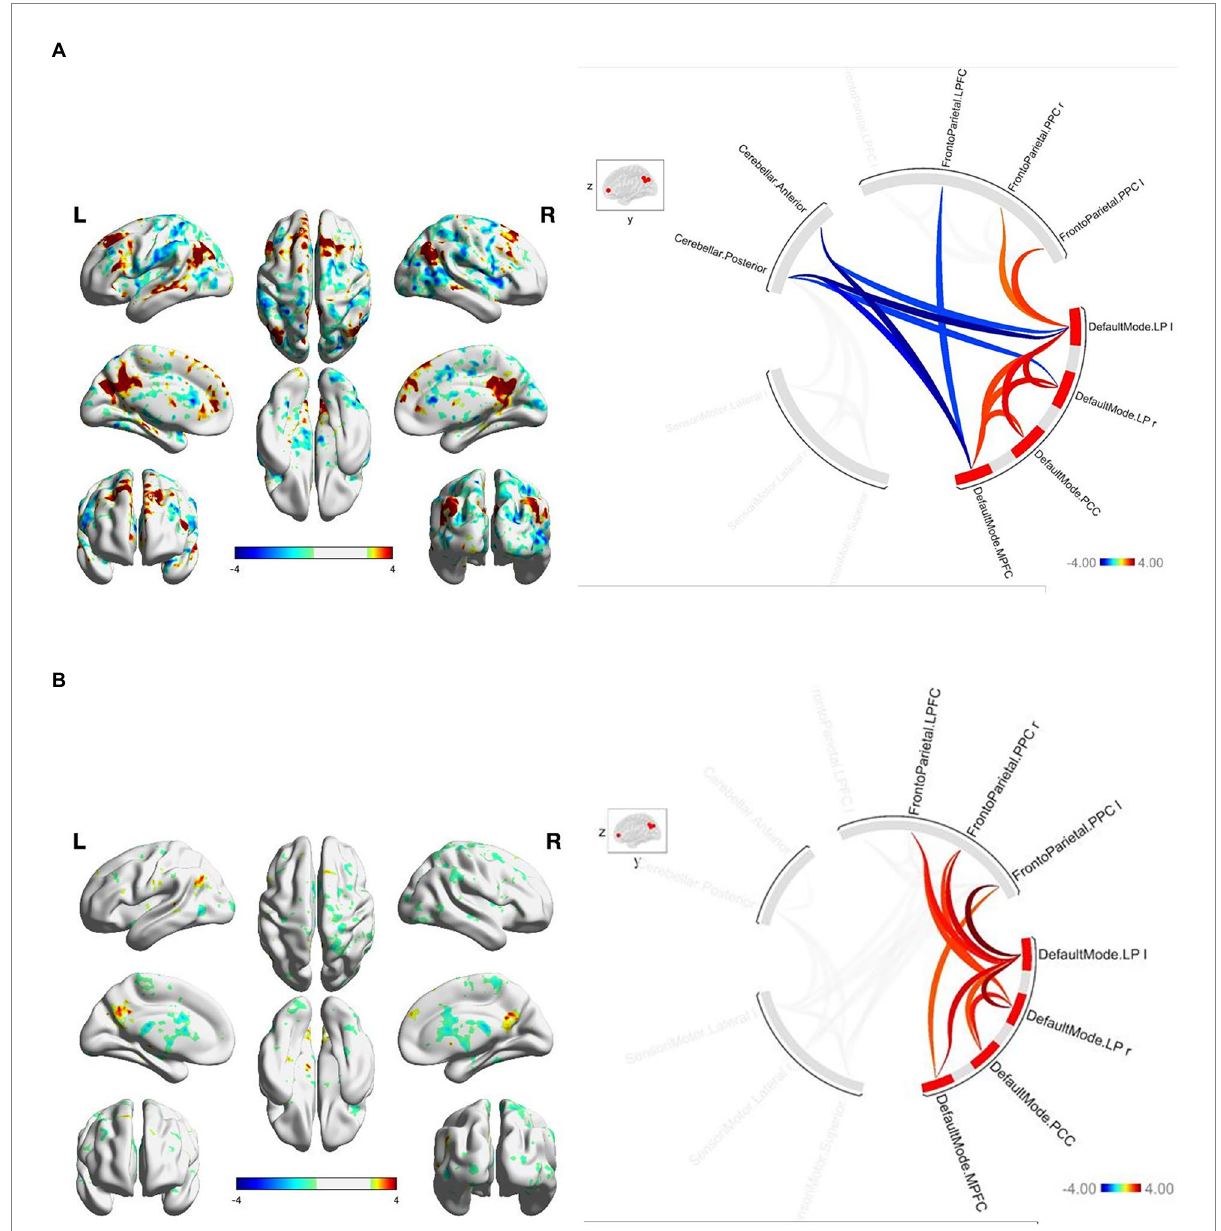
FIGURE 1 (A) FGA-related DMN connectivity at baseline. For connectome ring: bottom right quadrant contains nodes of the DMN, top right quadrant contains nodes of the FPN, the top left and bottom left quadrants contain nodes of the cerebellum and SMN. At baselight greater FGA score was associated with: greater within-network connectivity within the DMN (uncorrected p < 0.01); greater connectivity between the DMN and FPN (uncorrected p < 0.01); lower connectivity between the DMN and cerebellum (uncorrected p = 0.02). (B) FGA-related DMN connectivity over 26-weeks (26 week – baseline). For connectome ring: bottom right quadrant contains nodes of the DMN, top right quadrant contains nodes of the FPN, the top left and bottom left quadrants contain nodes of the cerebellum and SMN. At 26-weeks greater FGA score was correlated with: greater within-network connectivity within the DMN (uncorrected p < 0.01); greater connectivity between the DMN and FPN (uncorrected p < 0.01); Statistical brain maps were generated via general linear model (Z > 2.7, p < 0.05 FWE